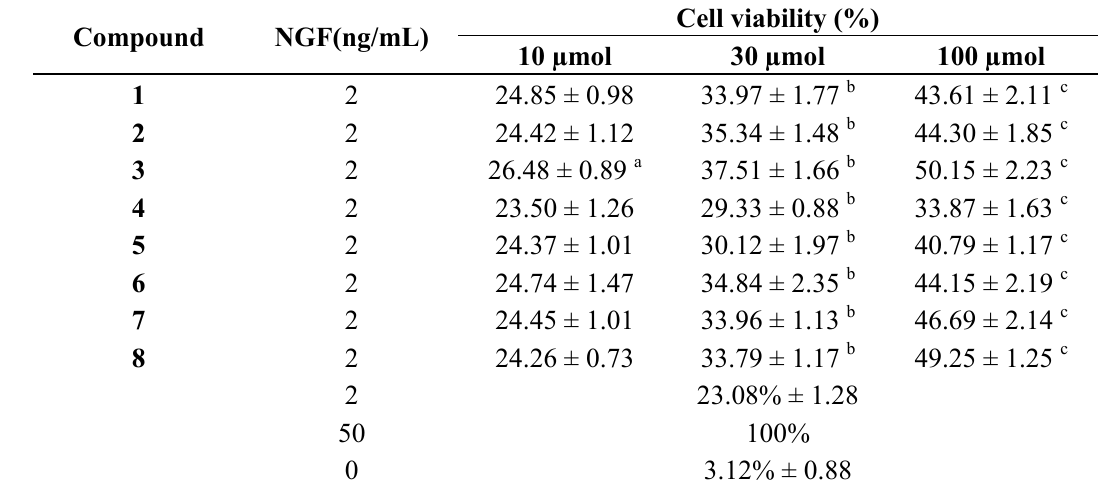
Table 2. Effects of compounds 1 – 8 on the proportion of neurite-bearing PC 12D cells in the presence of